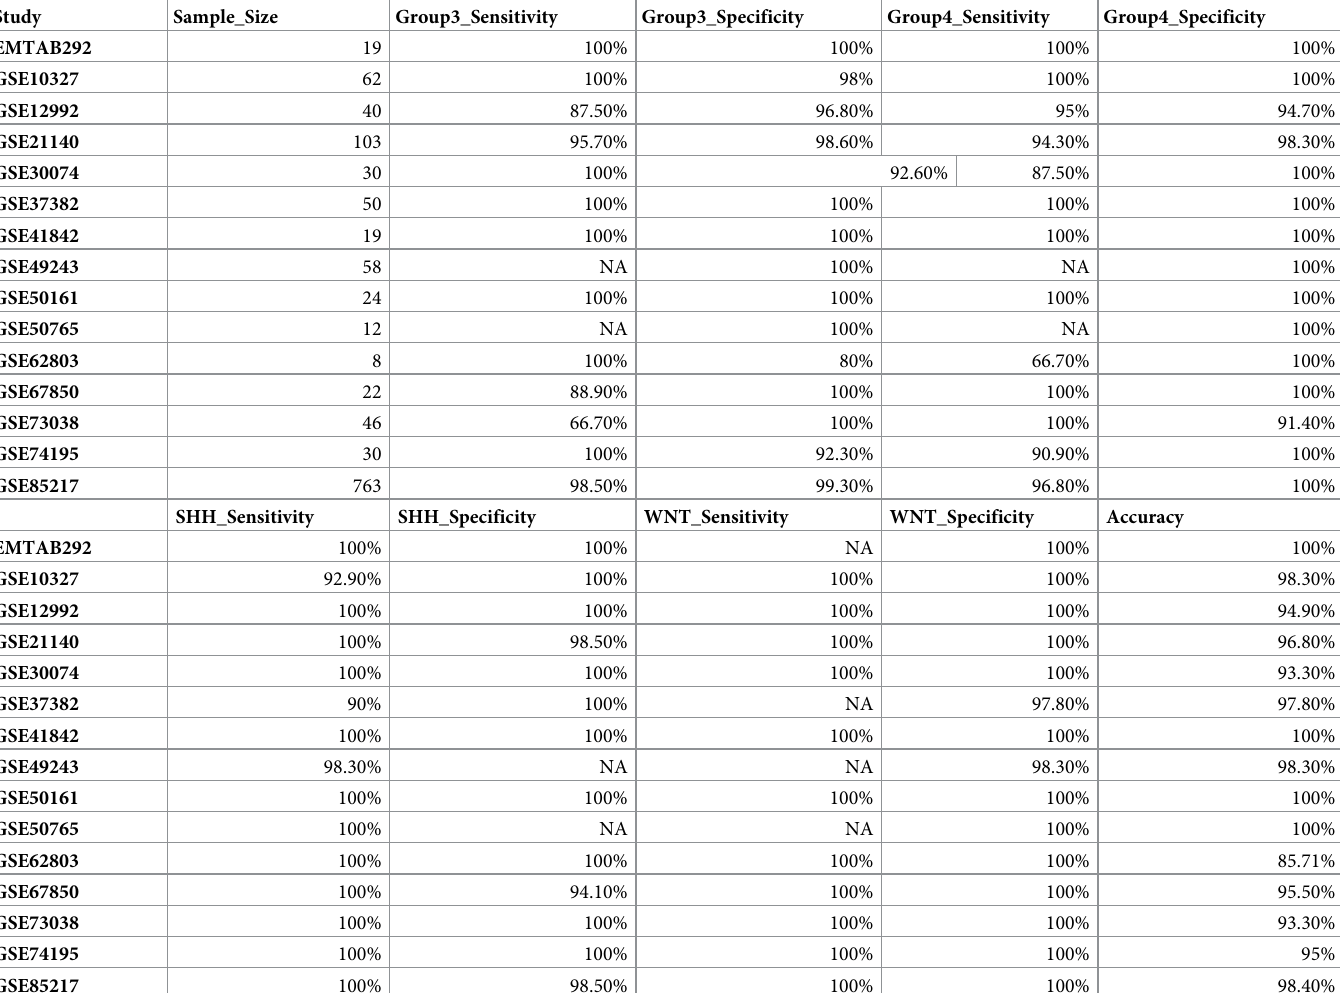
Table 2. Subtype-specific Sensitivity, Specificity and overall Accuracy across 15 test MB